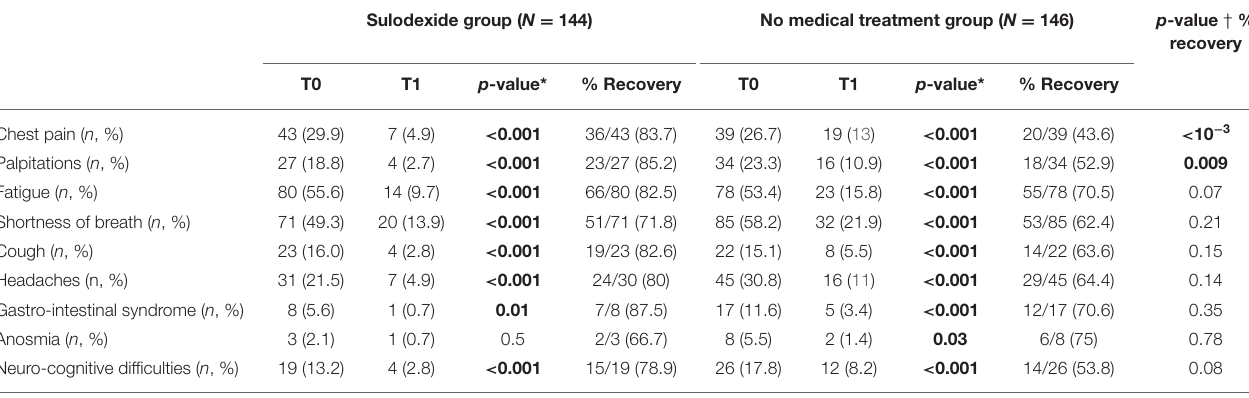
TABLE 2 | Evolution of the long-COVID-19 symptoms in the study groups. Sulodexide group ( N = 144) No medical treatment group ( N = 146) p -value † %